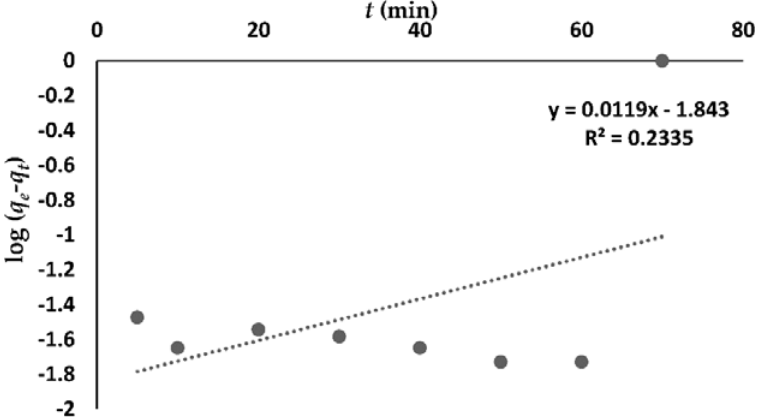
Figure 12. Pseudo-first-order plot of HDTMA-VMT 0.2M .